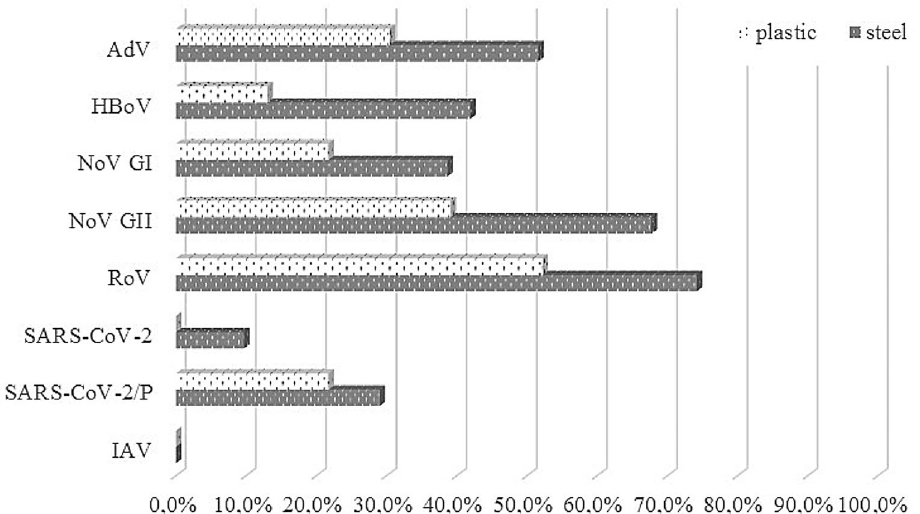
Figure 1. Percentage of positive samples on plastic and steel surfaces. Abbreviations: AdVs – adenoviruses, HBoV – human bocavirus, RoVs – rotaviruses, NoV GI – Norwalk virus genogroup I, NoV GII – Norwalk virus genogroup II, IAV – influenza A virus, SARS-CoV-2 – severe acute respiratory syndrome coronavirus 2, SARS- CoV-2/P – presumptive SARS-CoV-2 positive/other coronaviruses